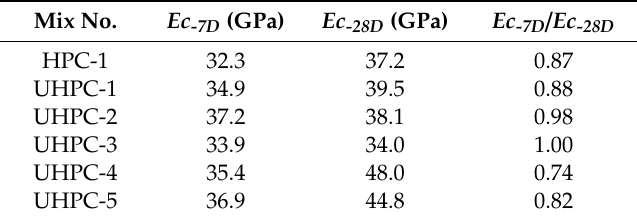
Figure 2. Stress–strain curves of concrete. Table 10. Development of elastic